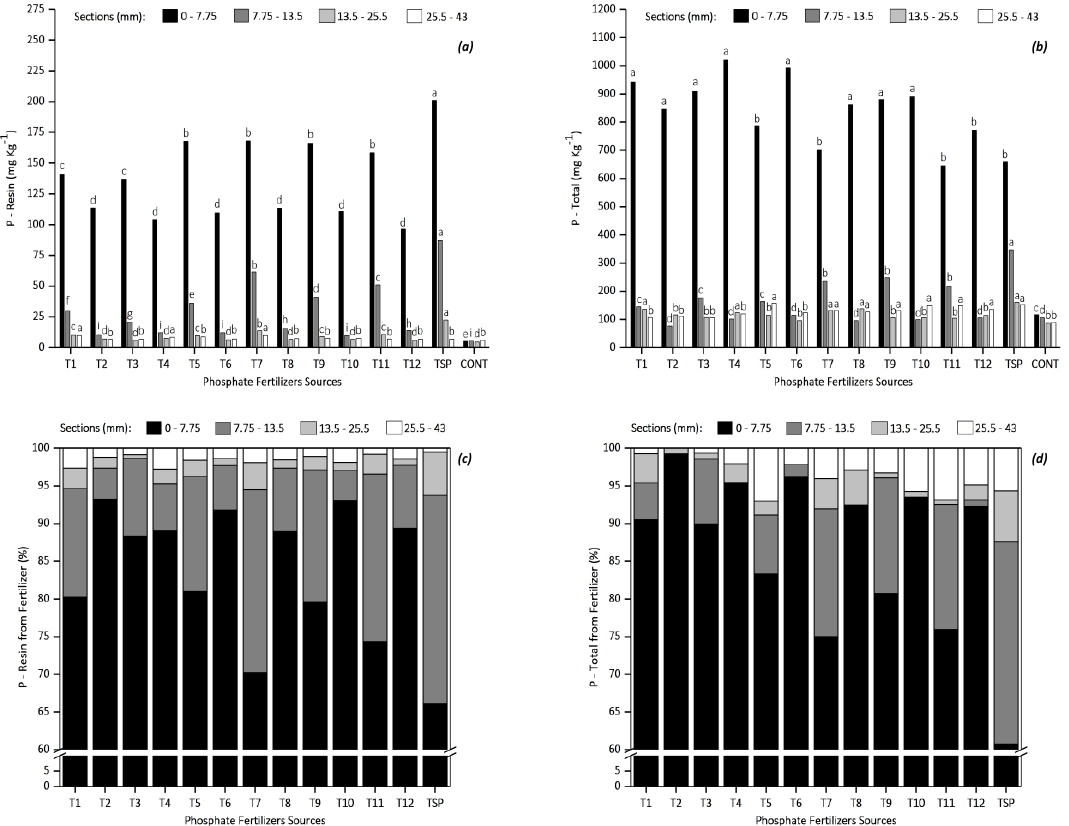
Figure 4. Soil available P (resin) ( a ) and total P content ( b ) in samples at distinct distances from the fertilizer granule application (radii of 0–7.75, 7.75–13.5, 13.5–25.5, and 25.5–43 mm) after five weeks of incubation. Mean values followed by the same letter for each soil layer do not differ by t -test (Scott–Knott, P < 0.05). Percent distribution of available P ( c ) and total P ( d ) from fertilizer in each layer (% P f S 1–4 ) calculated according to the equation proposed by Lombi et al. [35]: %P f S i = [(P f )S i * W i / Σ i = 1 − 4((P f )S i * W i ], where i is the layer of the petri dish (1 to 4); (P f )Si is the